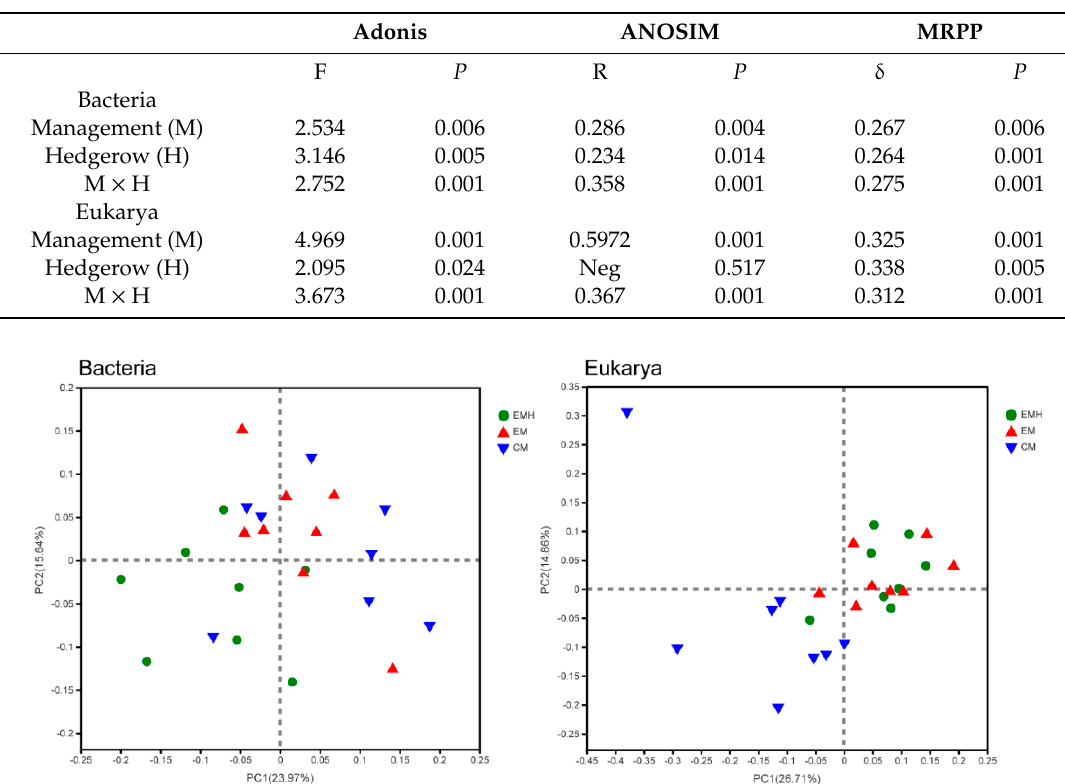
Figure 3. Principal coordinate analysis (PCoA) based on Bray–Curtis distances showing the differences in bacterial and eukaryotic communities among the three farming systems.